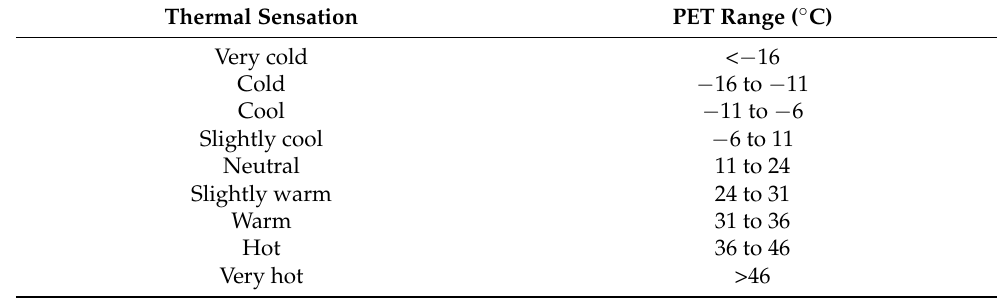
Table 4. Relationship between thermal sensation and PET for Tianjin residents in cold climate areas. Thermal